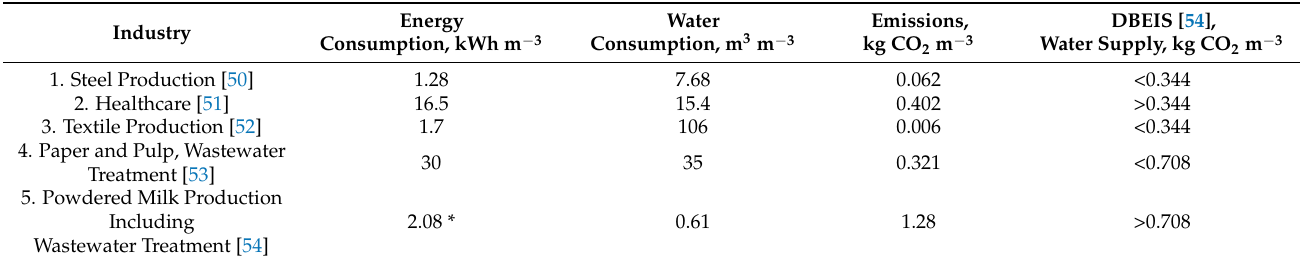
Table 4. Results of a simple carbon footprint calculation in water supply and treatment with energy and water consumption pro unit of a product [49,54,58–66].